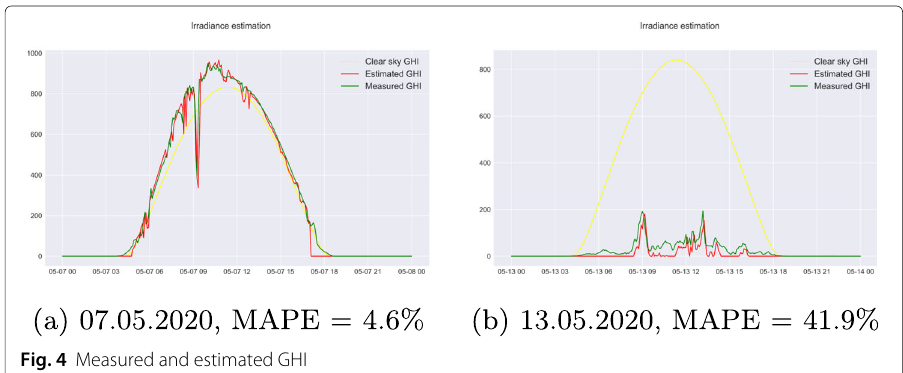
Fig. 4 Measured and estimated GHI